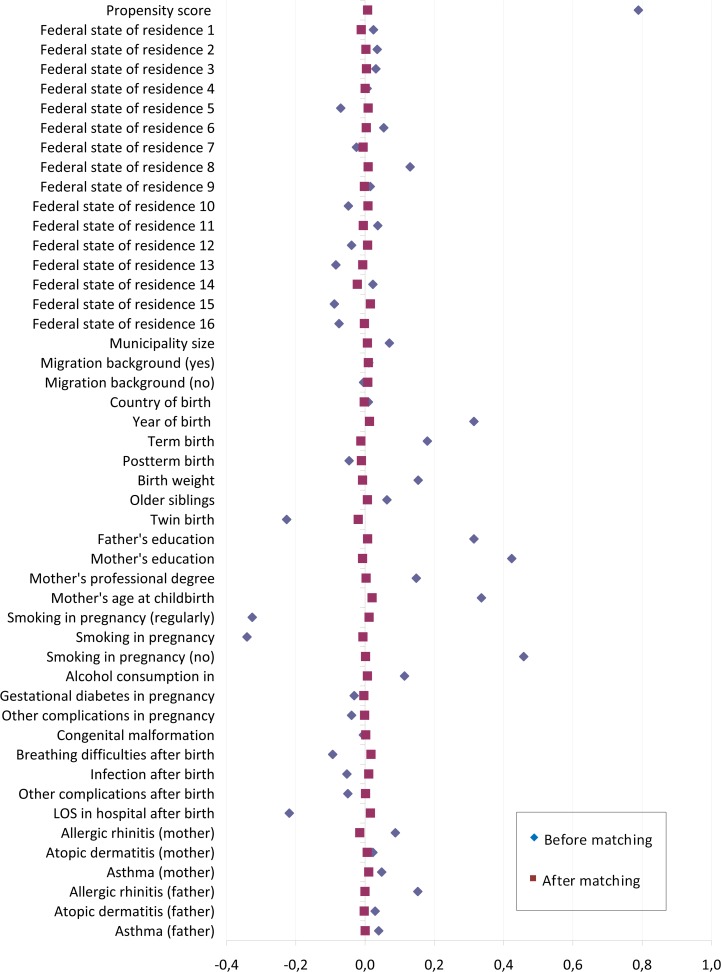
Standardized differences before and after matching.Dotplot of standardized mean differences (Cohen’s d) for the covariates included in the propensity score before and after matching.